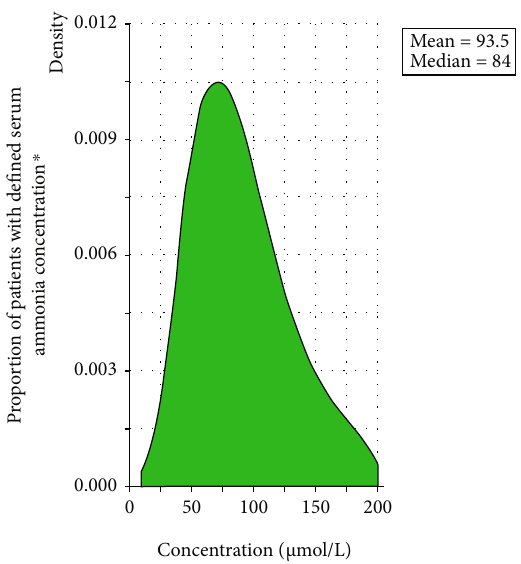
Figure 2: Serum ammonia distribution in cirrhotic patients with HE measured within ± 2 days of a con fi rmed HE event. HE: hepatic encephalopathy. ∗ N = 11,113